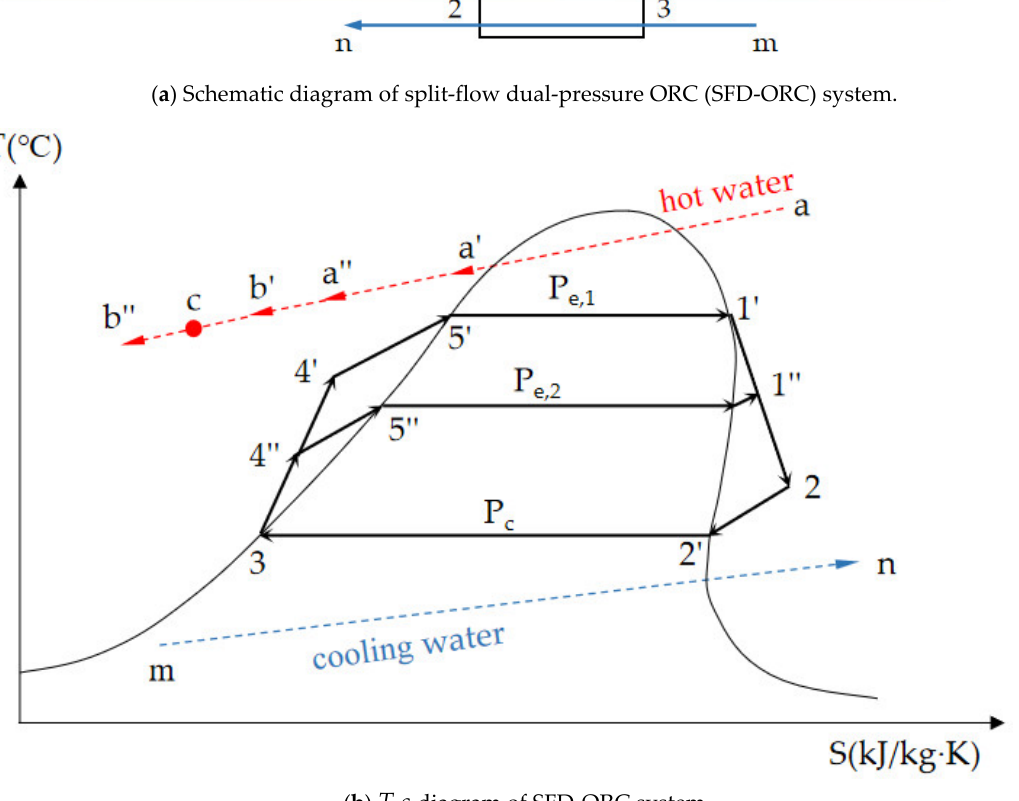
Figure 3. Scheme and the theoretical T - s diagram of SFD-ORC system.